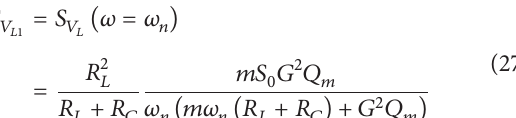
Figure 3: Mean power as a function of load resistance for different values of 𝐺 2 for 𝑄 𝑚 = 5.7